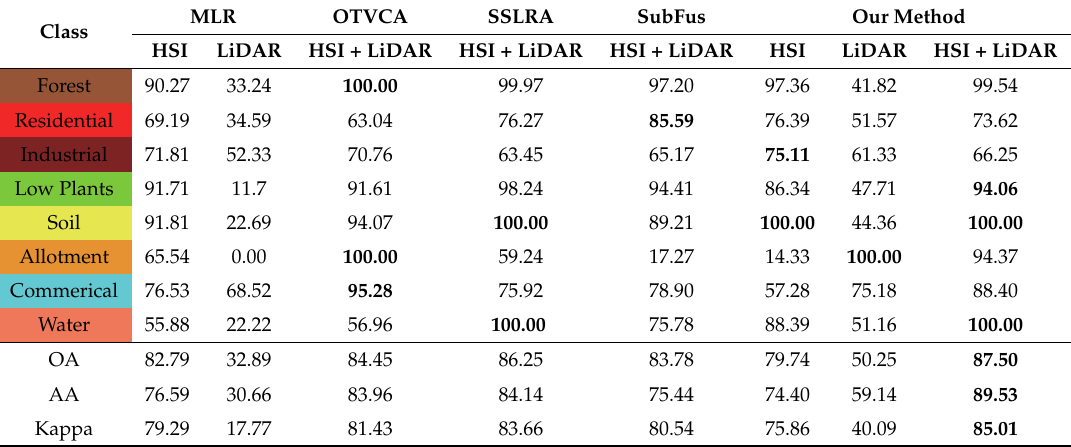
Table 3. Classification accuracies of all considered techniques on Berlin dataset.